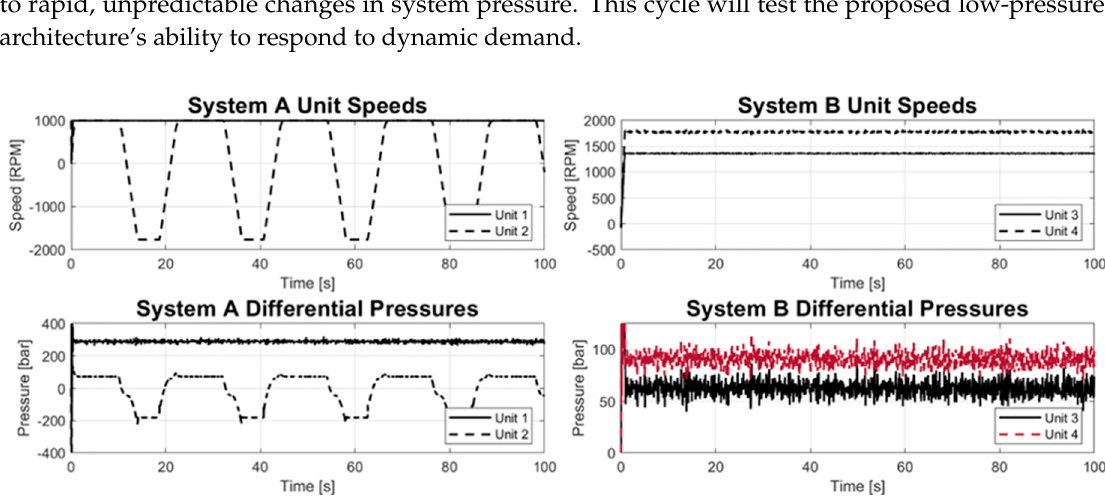
Figure 11. Reference system response to dynamic operating conditions.